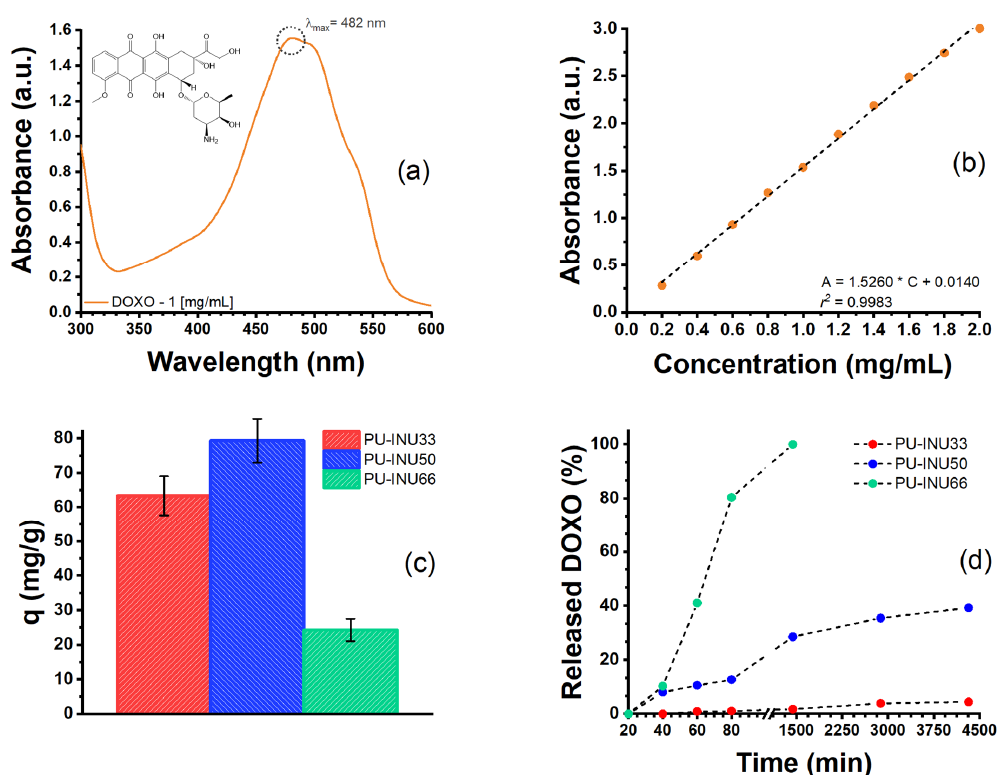
Figure 8. Application of PU–INU’s as drug delivery system of doxorubicin hydrochloride (DOXO). ( a ) DOXO UV–Vis spectra at 1 mg · mL −1 , ( b ) DOXO calibration curve with a linear fit of R 2 > 0.99, ( c ) sorption capacity (q, mg · g −1 ) of synthesized PU–INU, and ( d ) drug released relative to drug loading concentration of